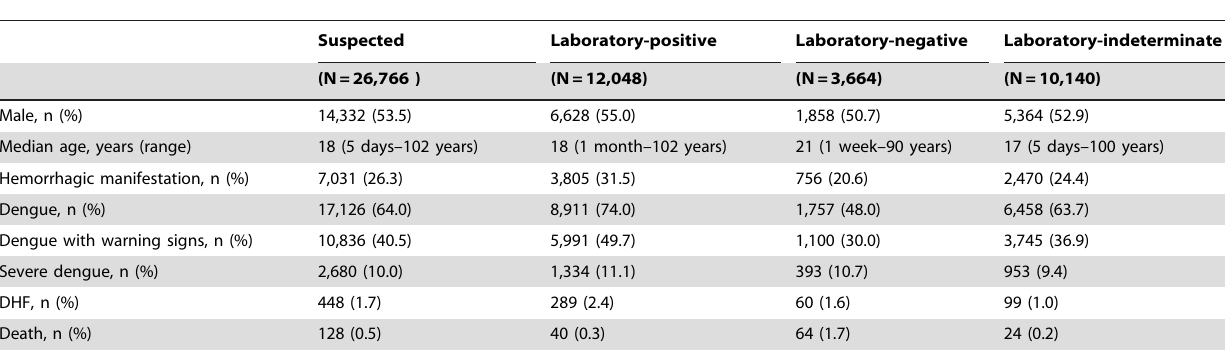
Table 1. Demographic and clinical characteristics of suspected dengue cases by diagnostic test result, Puerto Rico, 2010.